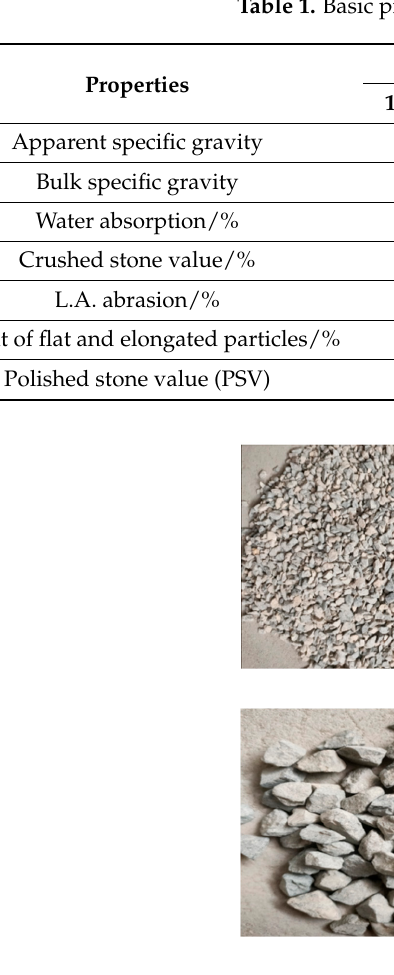
Table 1. Basic properties of coarse aggregates.